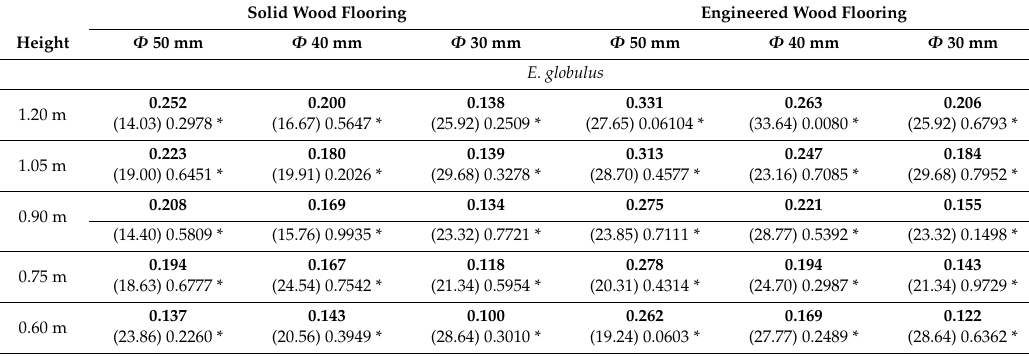
Table 6. Indentation depth (ID). Main descriptive